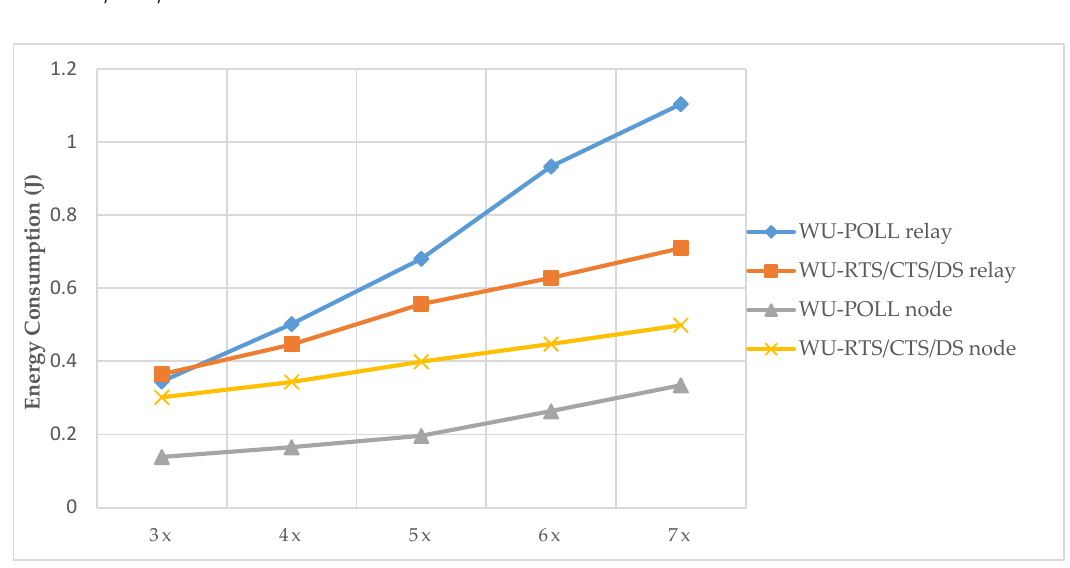
Figure 9. Relay energy consumption (X: Δx: number of nodes per the hop).